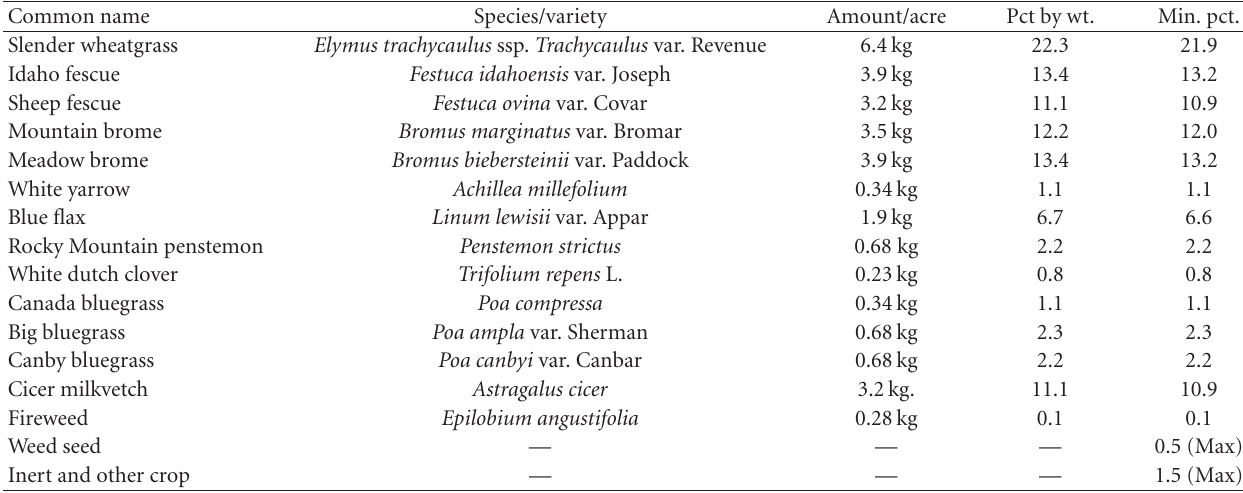
Table 2: Composition and application rates of standardized seed